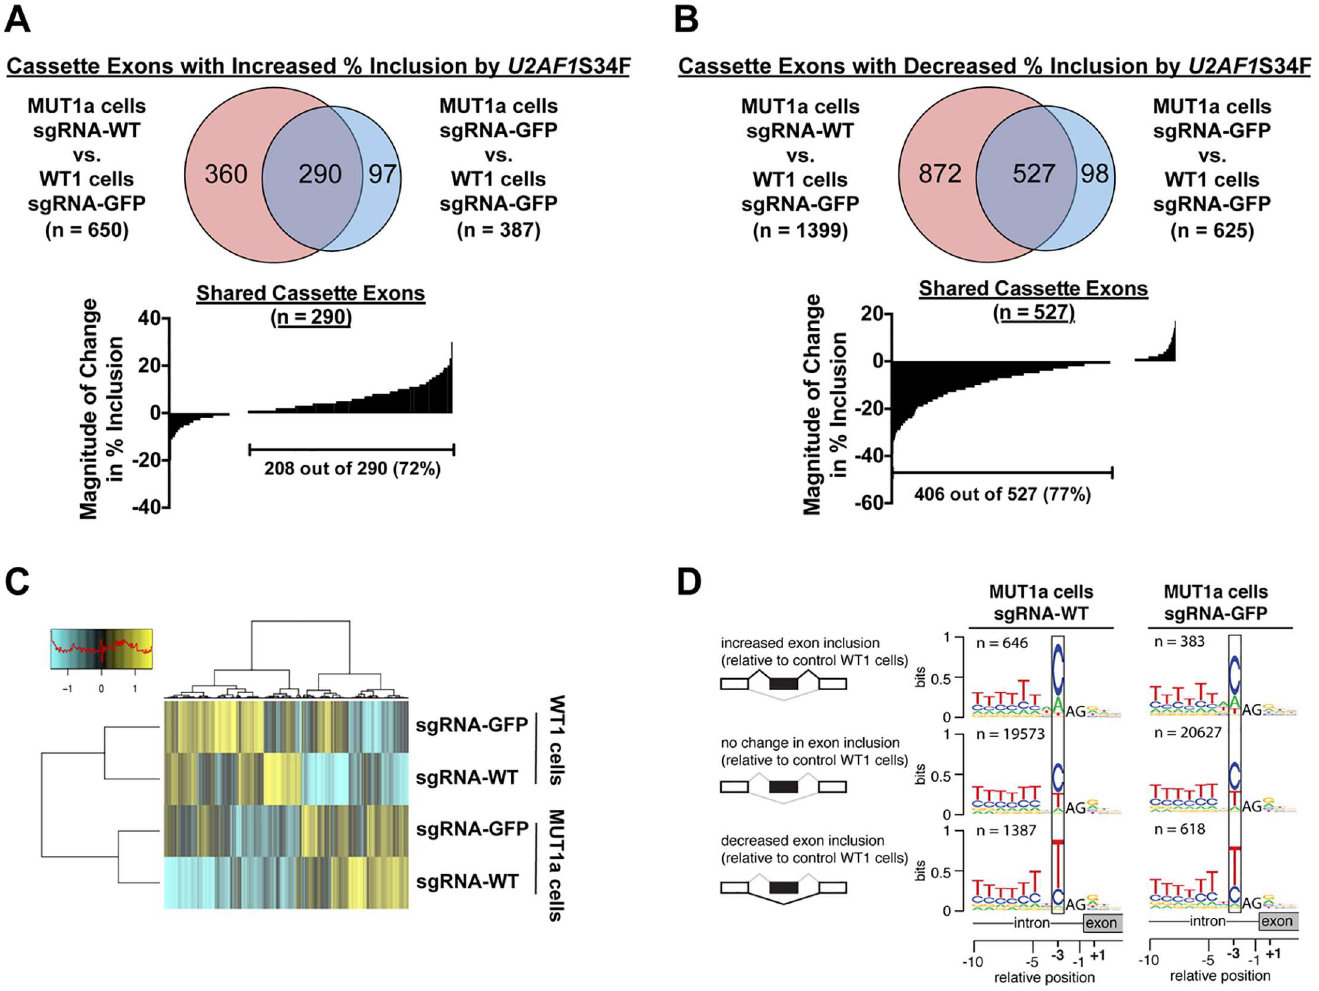
Fig 4. Increasing the ratio of S34F:WT gene products by disrupting the wild-type U2AF1 locus enhances S34F-associated splicing of cassetteexons. (A) . RNA-seq was performed for WT1 and MUT1a cells transduced with Cas9 and either sgRNA-GFP or sgRNA-WT. Upper panel: The Venn diagrams show overlapof 290 cassette exons that display at least a ten percent increase in inclusionlevels in MUT1a cells relative to levels in WT1 cells, with or without CRISPR-Cas9-mediated disruptionof wild-type U2AF1 . Lower panel: Increasing the S34F:WT ratio by disruptingwild-type U2AF1 enhancesthe magnitude of S34F-associated splicing. The “waterfall” plot depicts changes in percent inclusionlevels for all shared cassette exons identifiedfrom the Venn diagramwhen the wild-type U2AF1 locus was disrupted. Each vertical bar represents one shared cassette exon. (B) . The analysis shown in Panel A was repeated for cassette exons showingten percent or more decreasedinclusionin MUT1a cells. (C) . Heat map depictingthe inclusionlevels of all cassette exons that showed at least a 10% change in use among the treatment conditions. The dendrogram was constructed from an unsupervised cluster analysis. ( D ). Enhanced features of S34F-associated logos at 3 0 splice acceptor sites after disruptionof wild- type U2AF1 . Sequence logos were constructed as in Fig 1A, based on the indicated